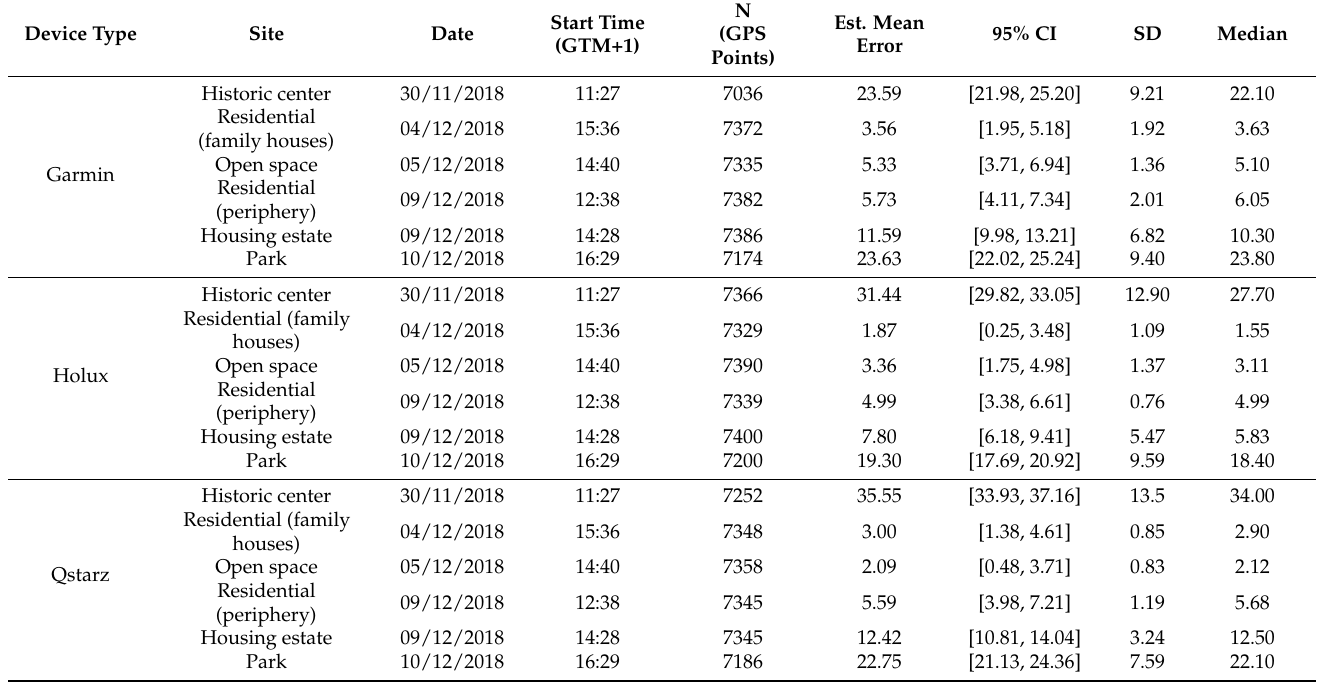
Table 2. Average deviation (m) by device type and the type of environment.